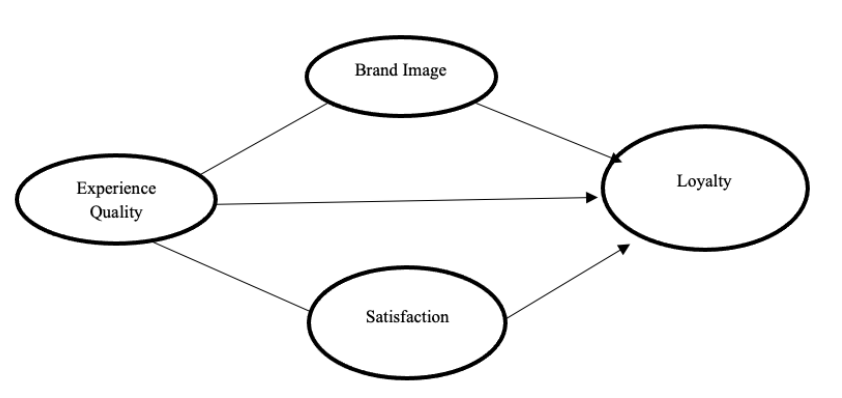
Figure 1: Conceptual Model of the Study; Source: